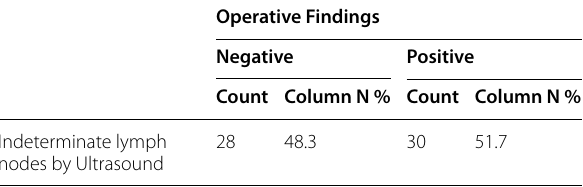
Table 3 Correlation between indeterminate lymph node